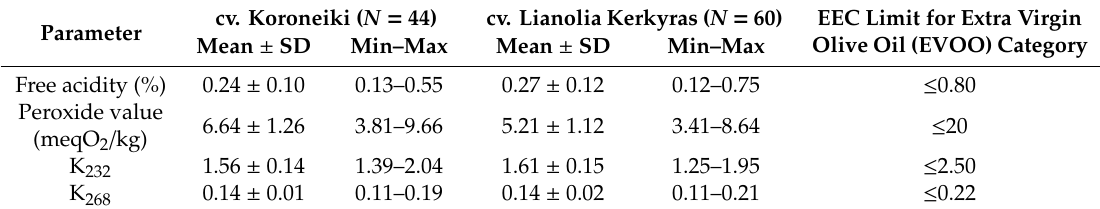
Table 1. Quality indices for the examined Koroneiki and Lianolia Kerkyras olive oils from the coastline region of Western